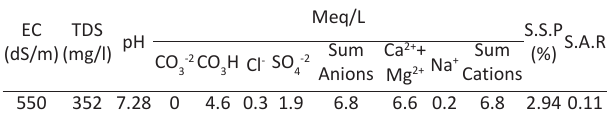
Table 3 - irrigation water chemical characteristics